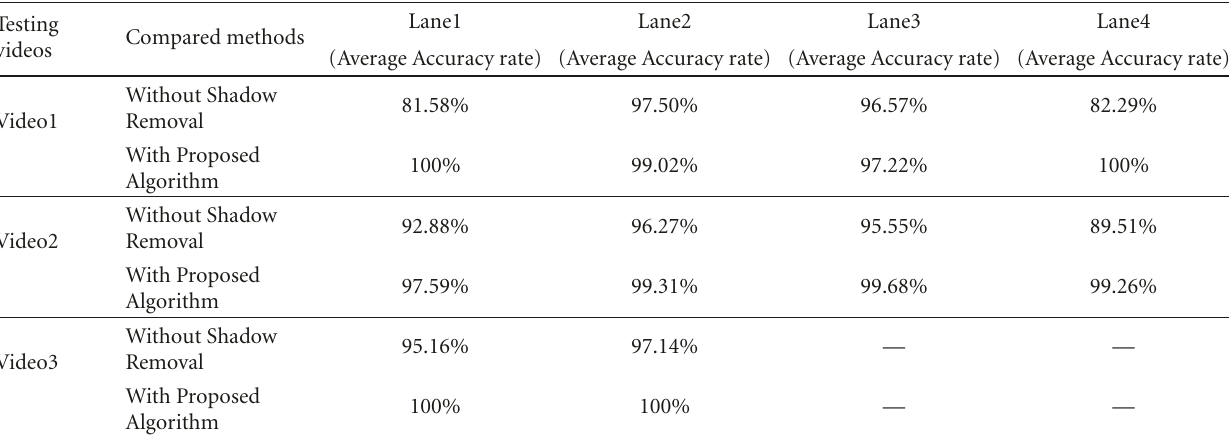
Table 3: Vehicle counting